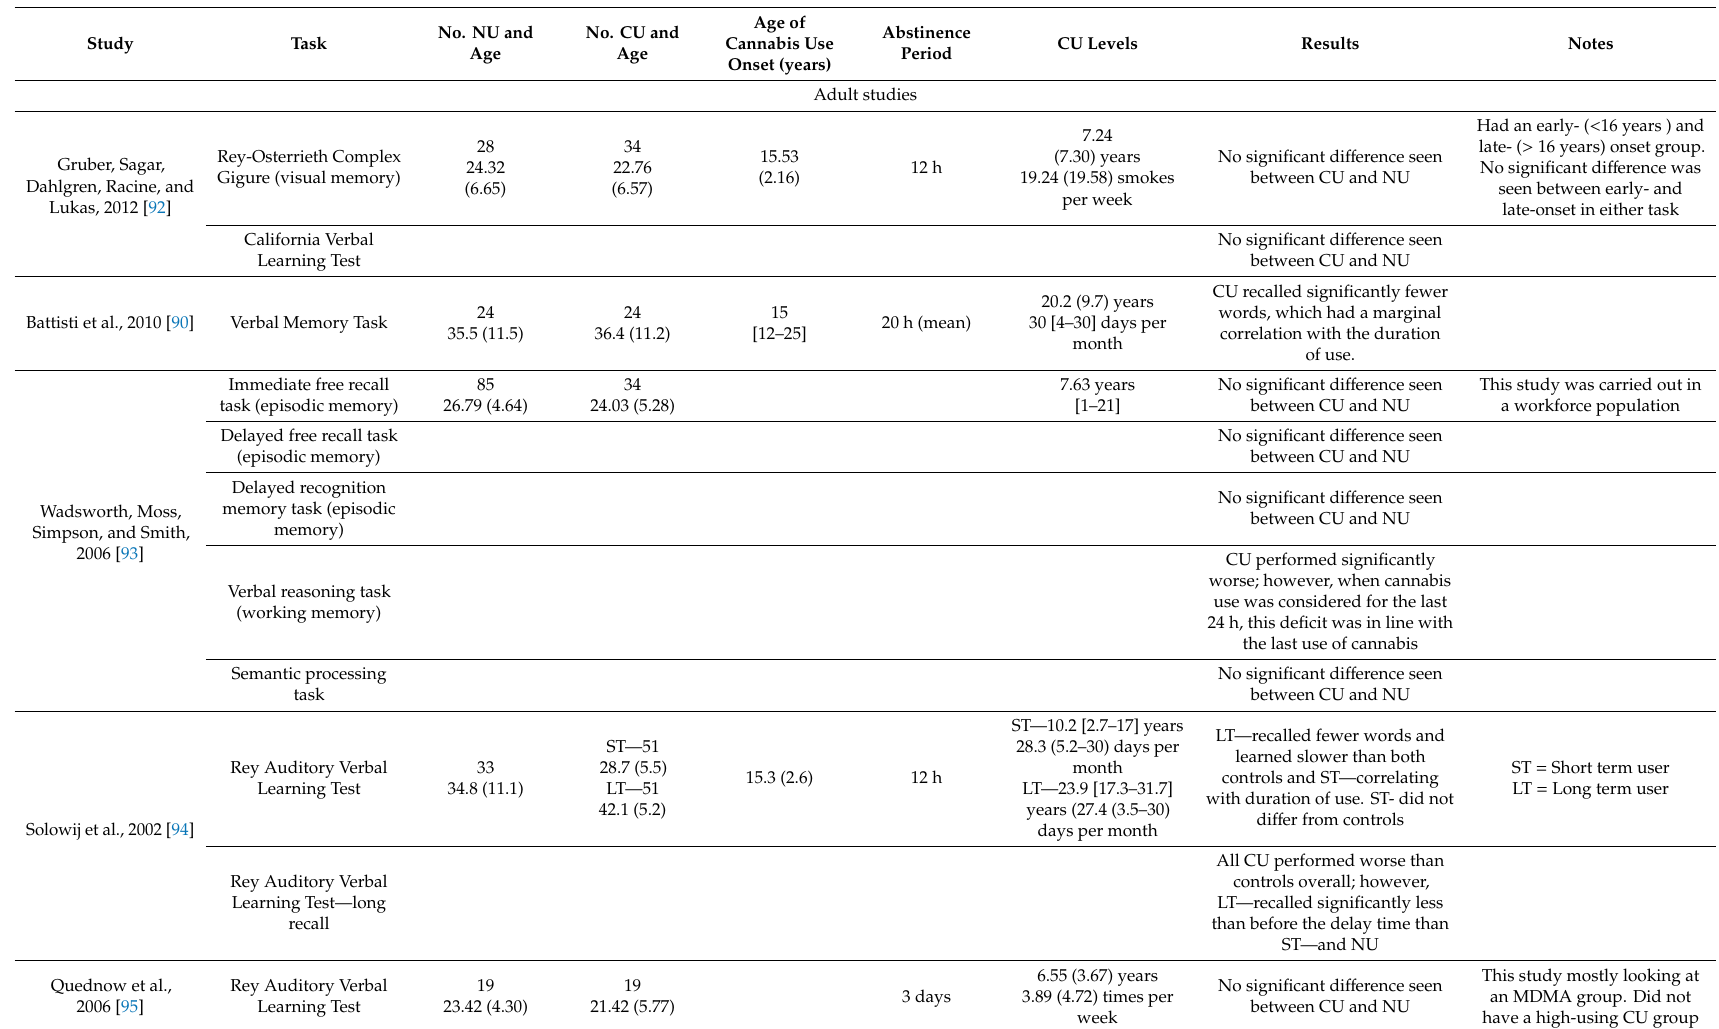
Table 2. Memory performance studies comparing cannabis users to non-using